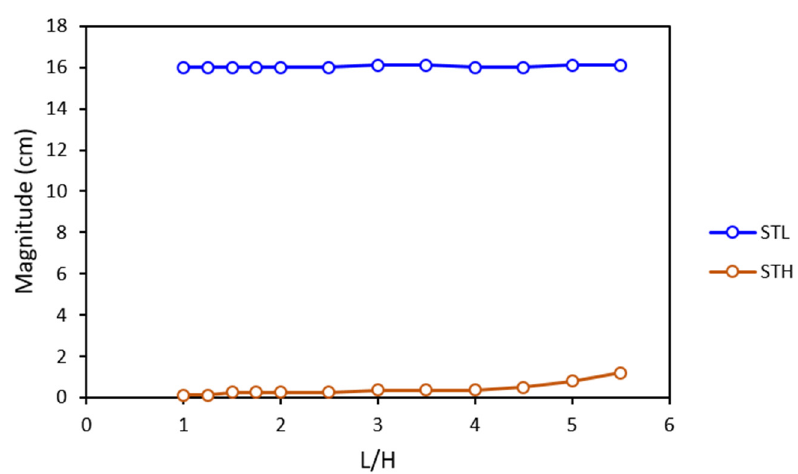
Figure 19. Effect of building length on sand accumulation around single-standing buildings. (See Figure 16 for explanation of symbols).